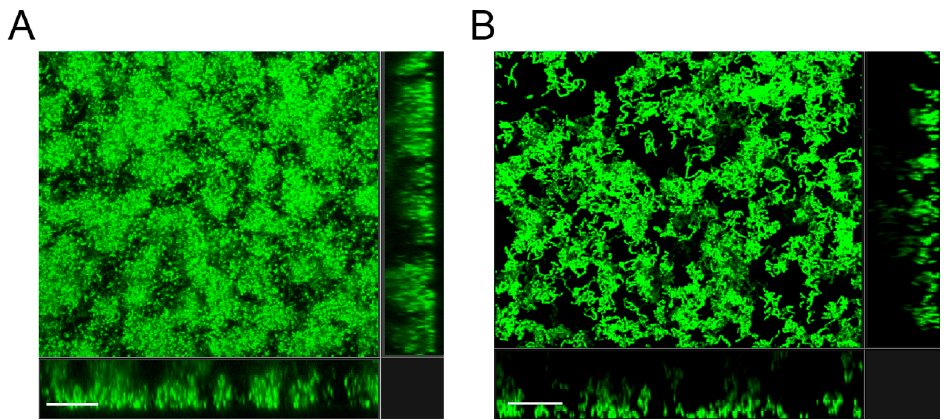
Figure 3. Confocal laser scanning microscopy (CLSM) micrographs of biofilms formed by the S. mutans UA159 wild type ( A ) and pgmA mutant ( B ) on submerged glass surfaces. The central images show 3-D projections and the flanking images represent vertical sections of the biofilms. Bars correspond to 20 µm.